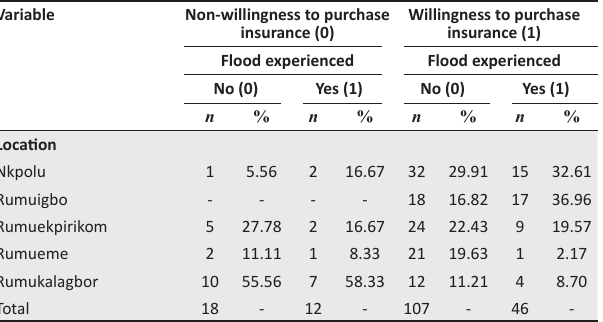
TABLE 4c: Cross-tabulation of differences in location among respondents characterised by willingness to purchase insurance.